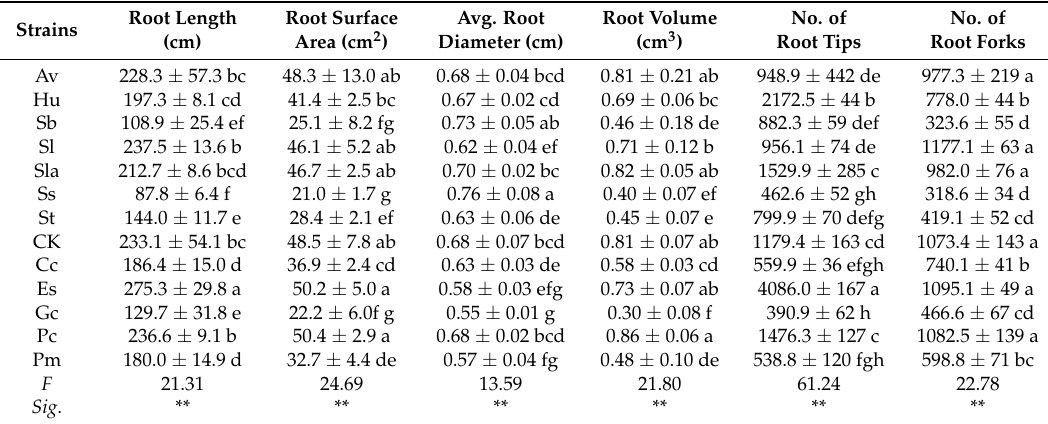
Table 2. Effect of inoculation ECMF and DSE on root morphological